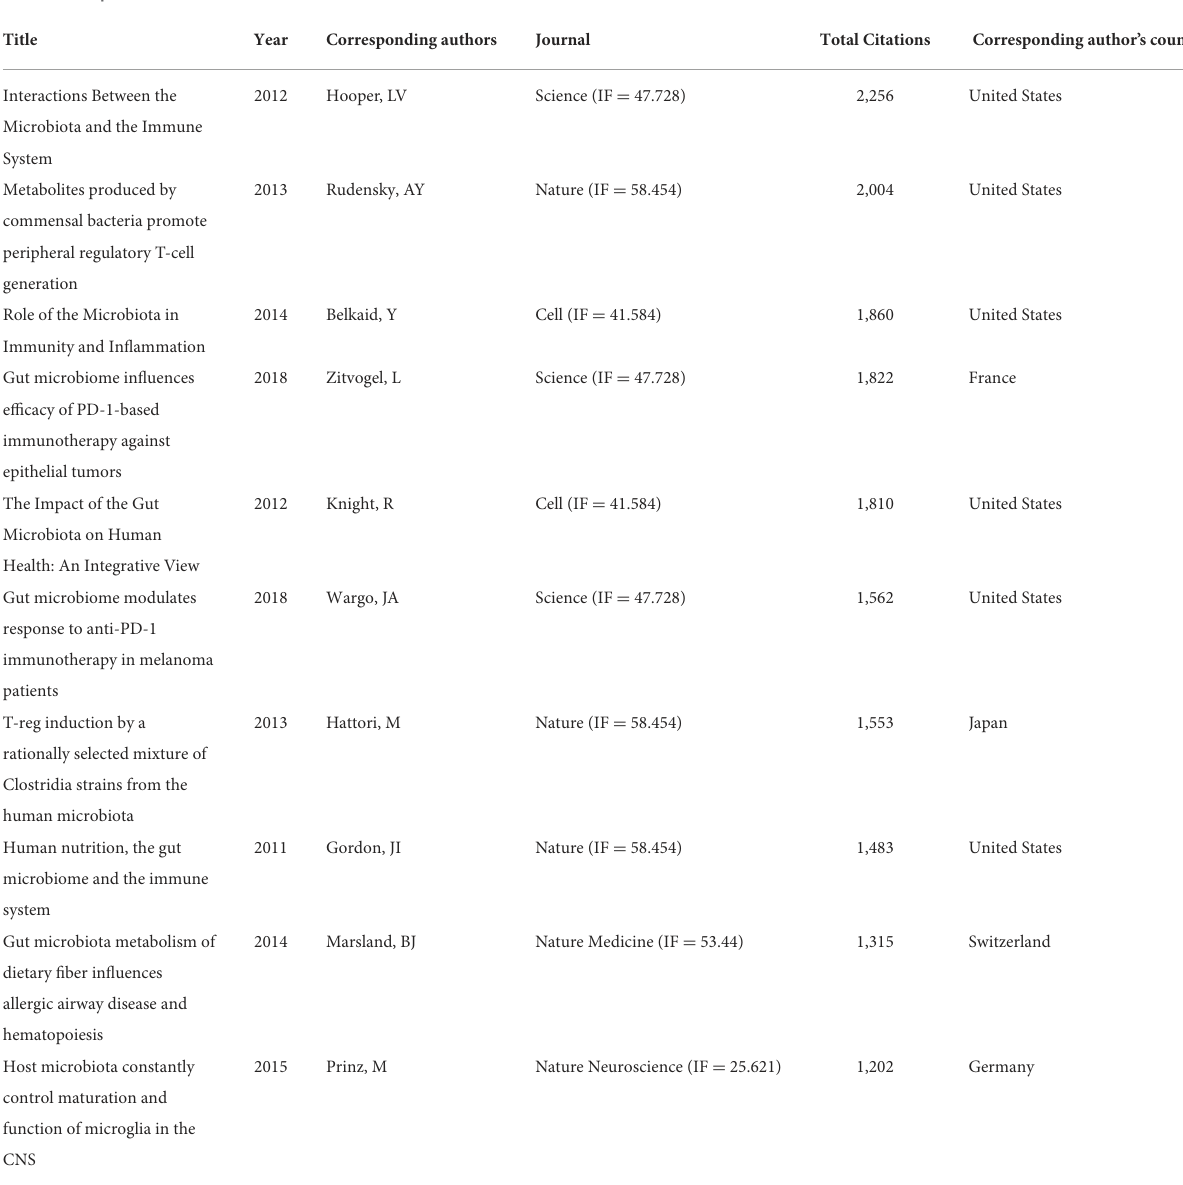
TABLE 1 Top 10 articles in the sum of citations.